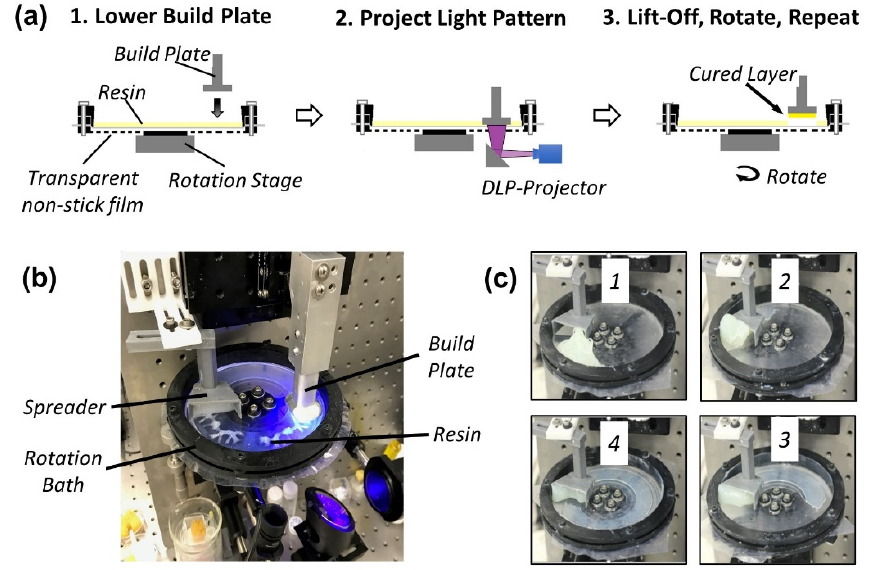
Figure 1. Printing process for paste-SLA printer. ( a ) Build plate and printed structure descend into resin bath from above to trap a thin layer of resin, which is then illuminated from below a transparent bath. Bath rotation recoats and exposes fresh resin. ( b ) Picture of paste-SLA printer during illumination. ( c ) Pictures of the recoating process of a 100,000 Pa · s silicone